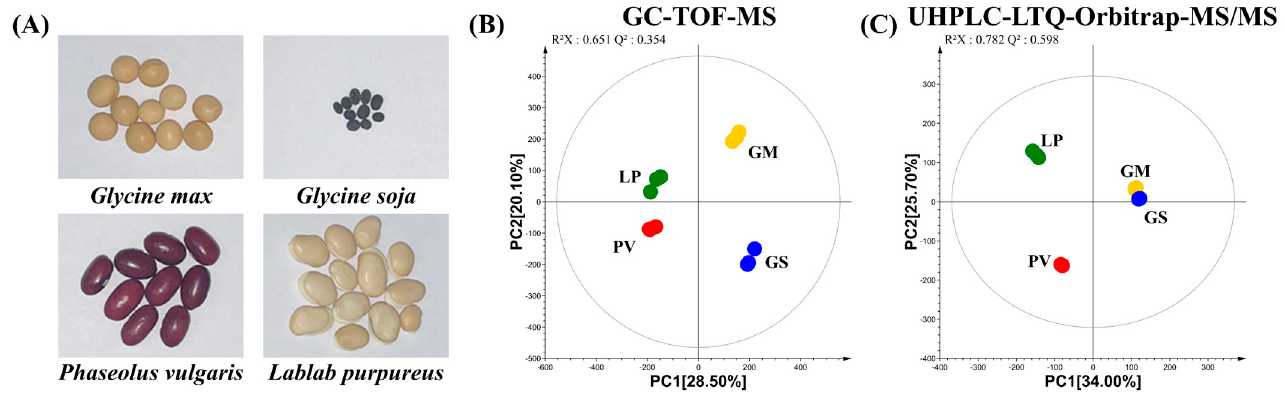
Figure 1 . Photographs of the four types of beans ( A ), and a principal component analysis of the metabolites in the four beans before fermenting. The methods included gas chromatography time- of-flight mass spectrometry (GC-TOF-MS) ( B ) and liquid chromatography-linear trap quadrupole- orbitrap-tandem mass spectrometry (UHPLC-LTQ-Orbitrap-MS/MS) ( C ). ( ● (GM): G. max , ● (GS): G. soja , ● (PV): P. vulgaris , ● (LP): L. purpureus ).